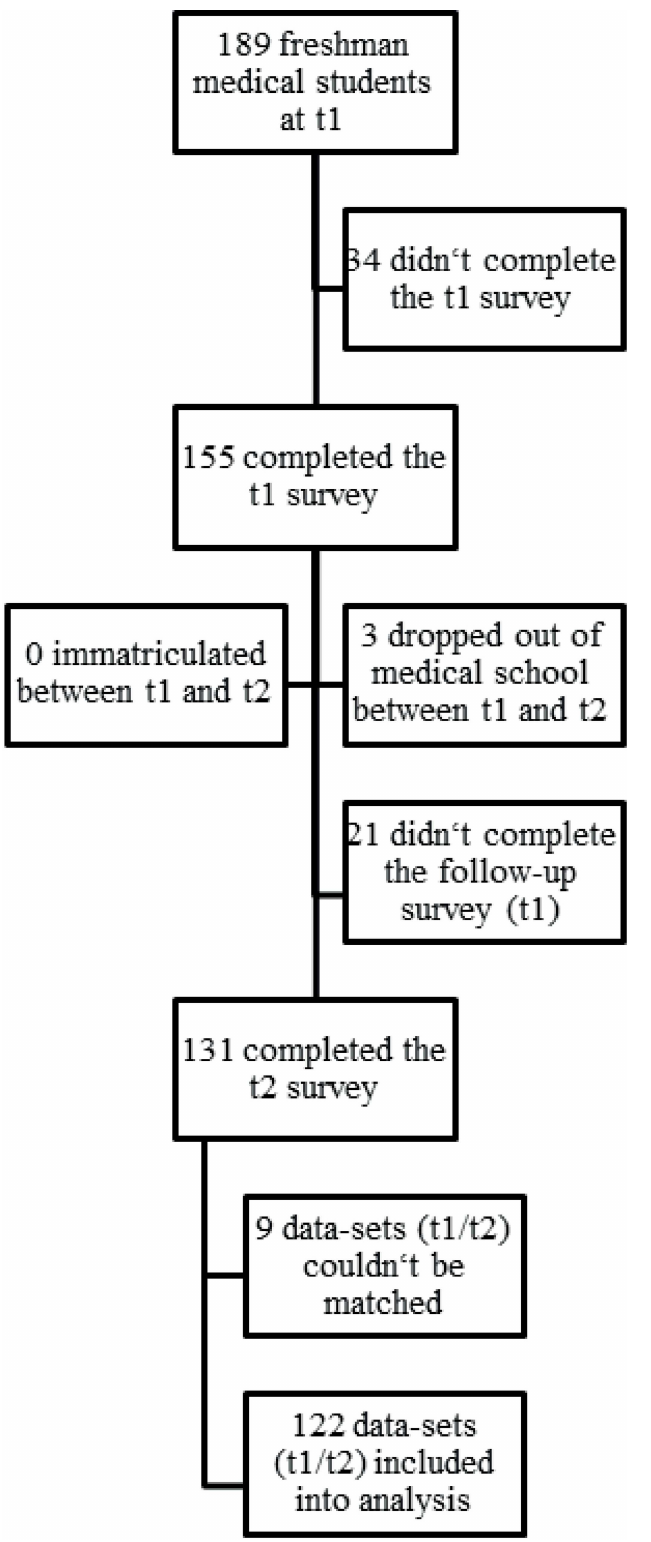
Fig 1. Participant flow.